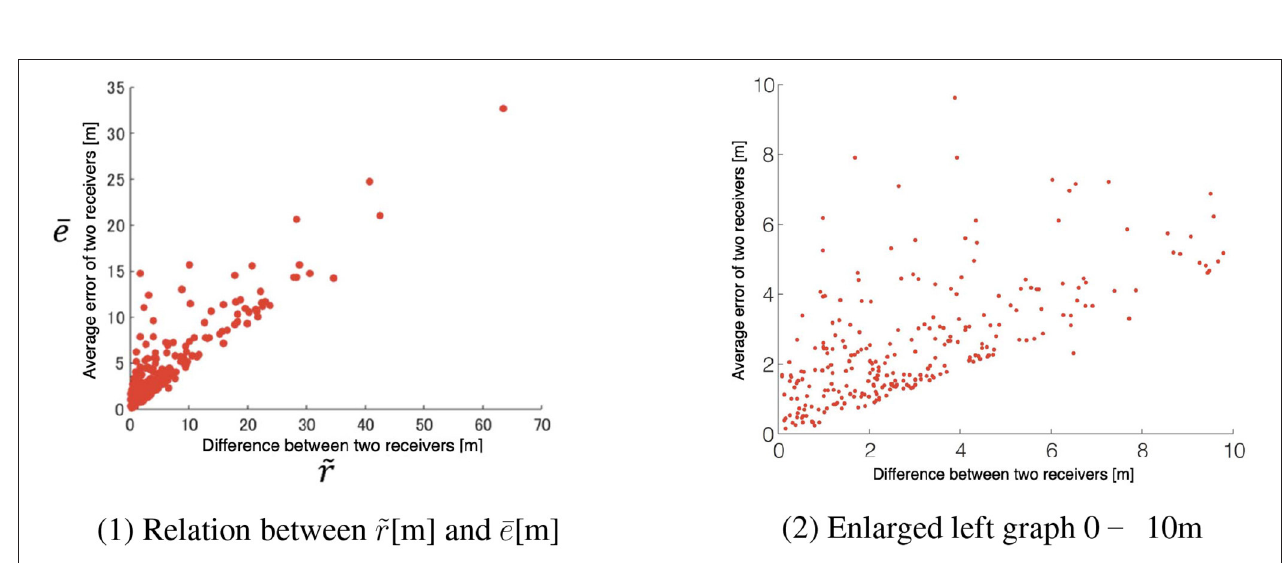
FIGURE 5 | Relationship between the distance of two receivers and the